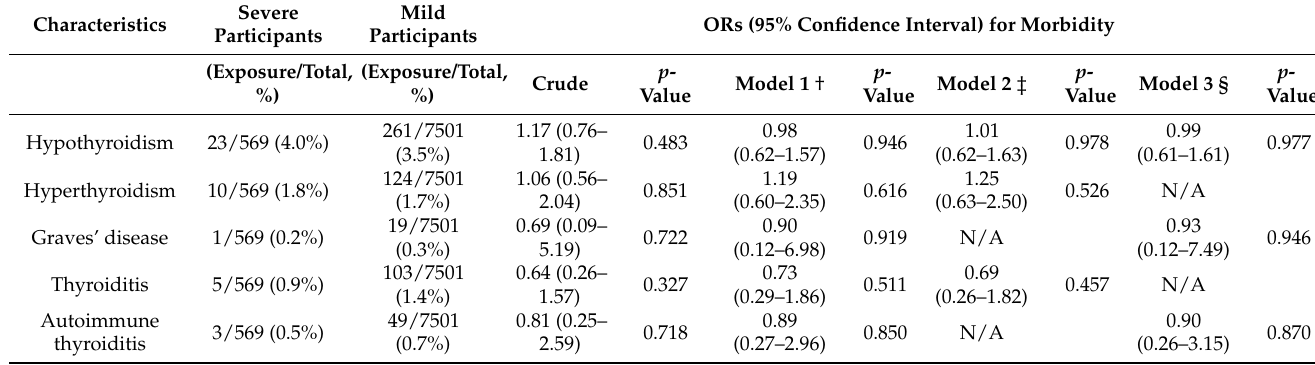
Table 3. Odds ratios of each thyroid disease for morbidity in COVID-19 participants.